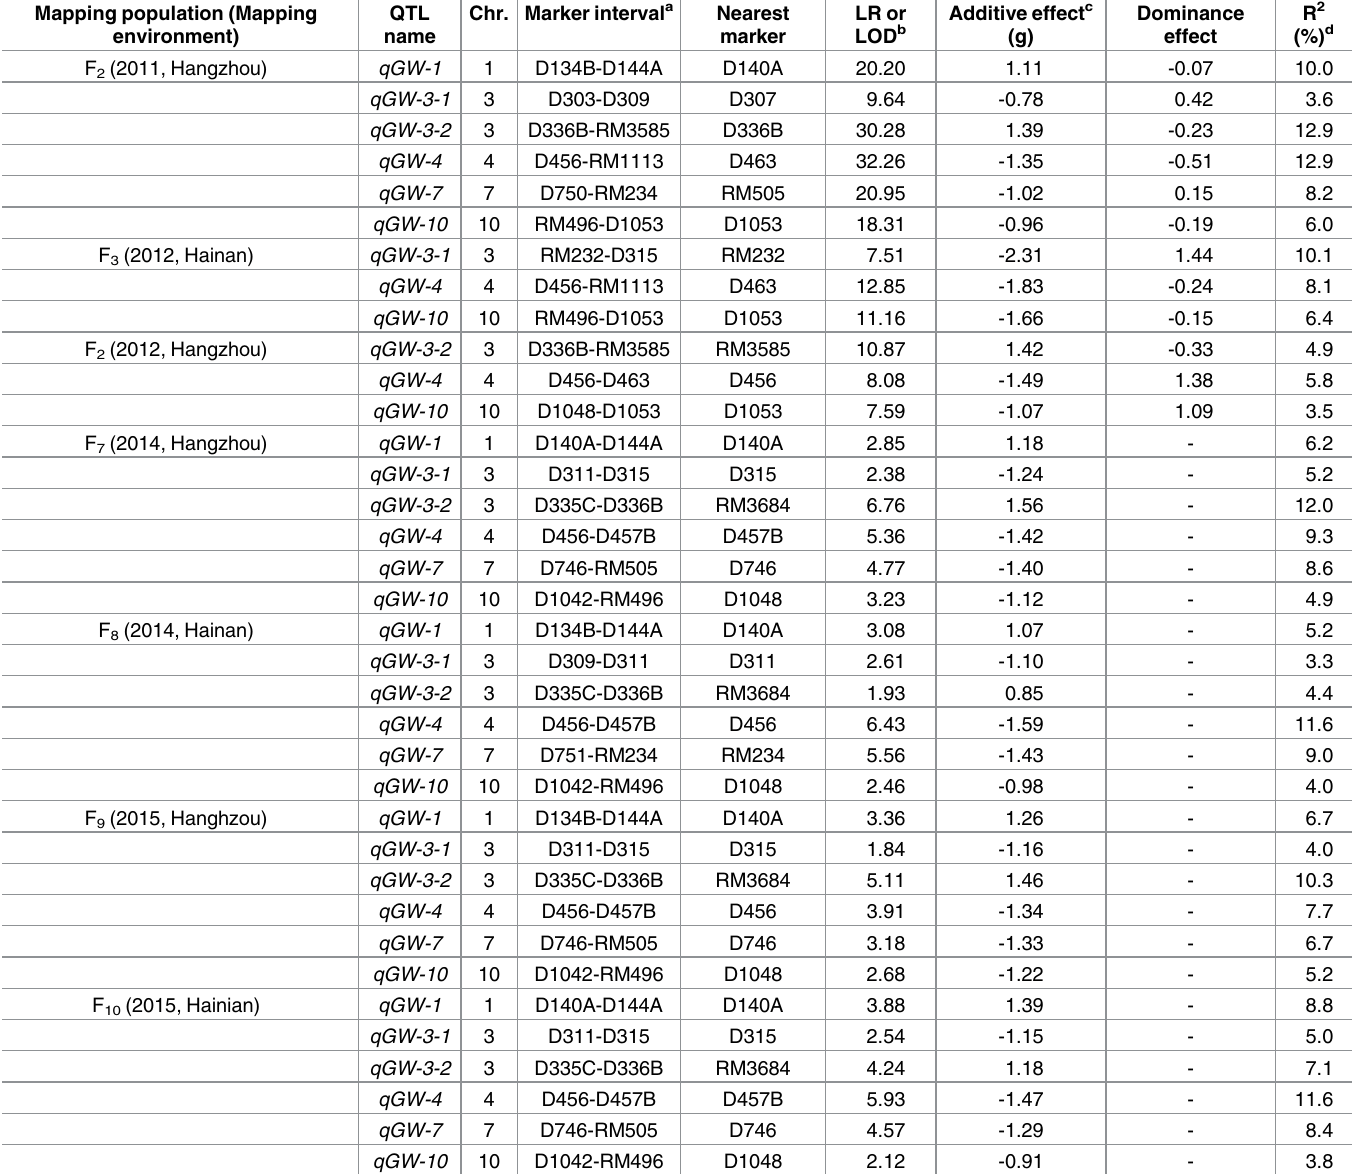
Table 1. Grain-weight-QTLs detected by multiple interval mapping in the seven mapping populations, derived from ‘Lemont’ × ‘Yangdao 4’ and planted in seven environments. Mapping population (Mapping